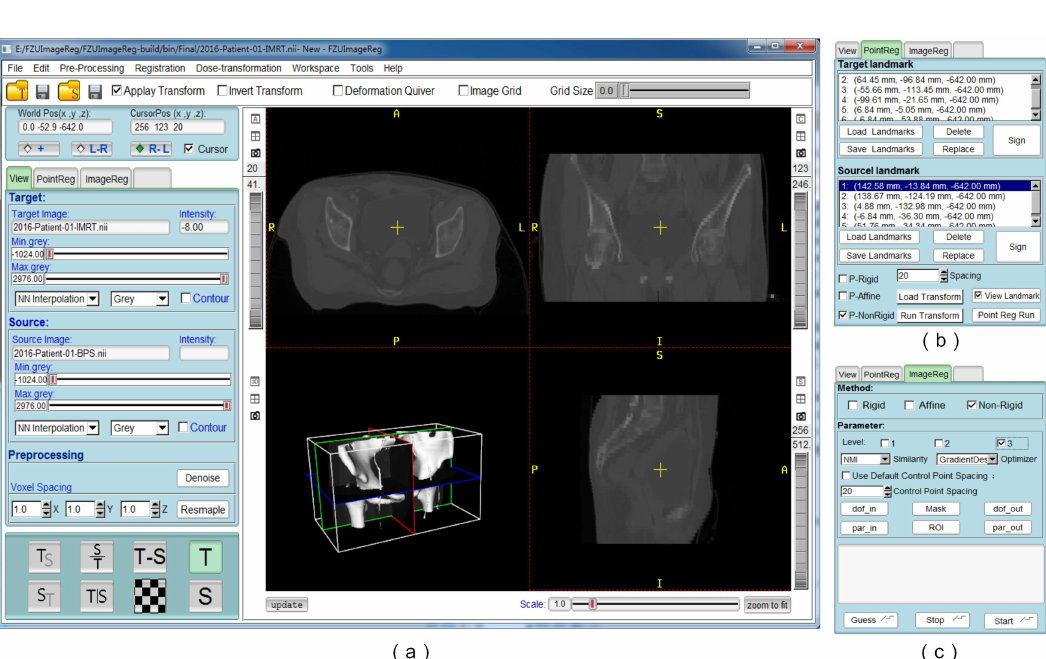
PLOS ONE | https://doi.org/10.1371/journal.pone.0174926 April 7,